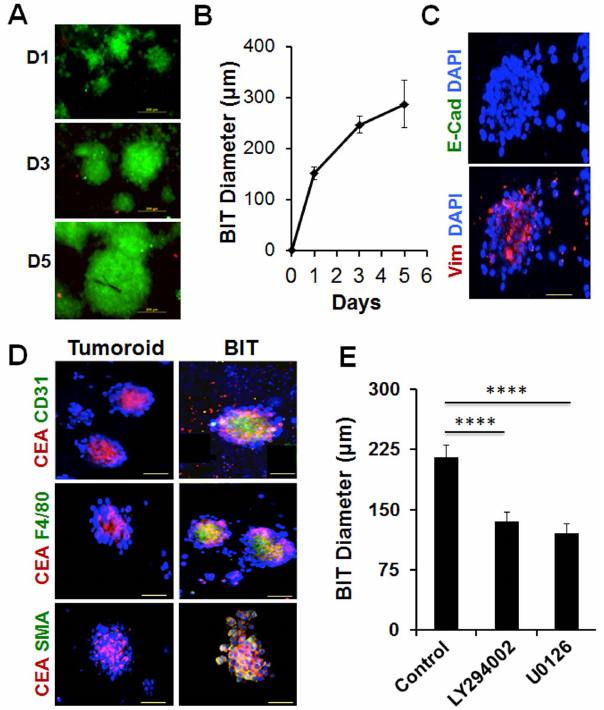
Figure 6. Culturing tumor biopsies on 3P scaffold. (A–B) FNA of implanted LLC1 mouse tumors were cultured on 3P scaffolds for the indicated time. Cells were stained with calcein AM/EthD-1 (A). The average size of BITs on 3P scaffolds from day 1 to day 5 is shown (B). (C) BITs were fixed and immunostained for E-cadherin (green), vimentin (red) and DAPI (blue). (D) LLC1 tumoroids and BITs were dual- immunostained for CEA (red) and either CD31, F4/80 or SMA (green) and DAPI (blue). Scale bar=100 m m. (E) BITs (day 2) were treated with 1 m M each of LY294002 or U0126 for 3 days. The average size of BITs on 3P scaffolds (n=10 controls, 55 LY294002 and 50 U0126) shown. Scale bar=200 m m.